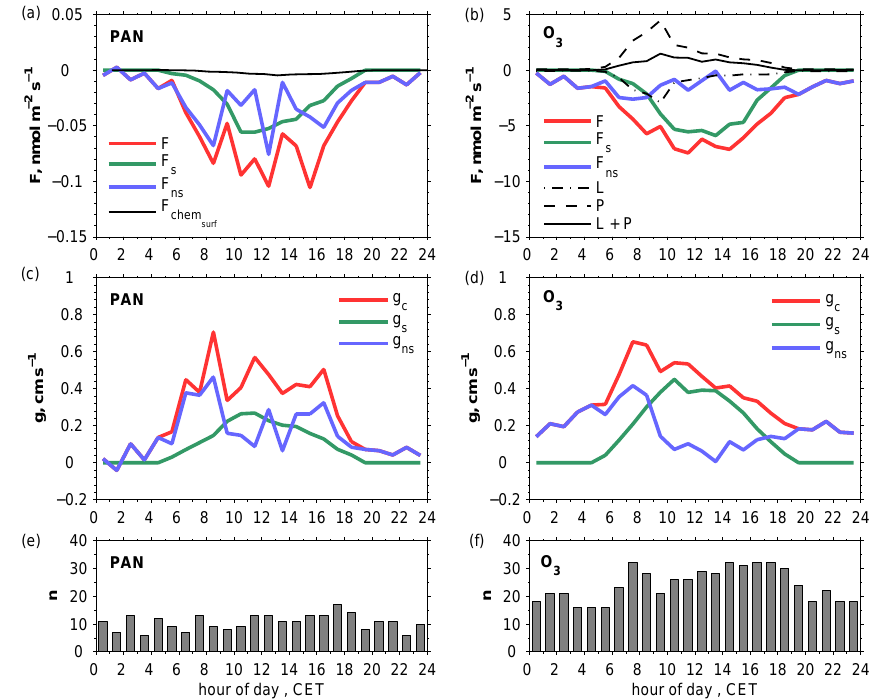
Figure 4. Flux partitioning of PAN (left column) and O 3 (right column) deposition into stomatal and non-stomatal pathways at the Mainz Finthen grassland site. Shown are diurnal median values for the period from 19 August to 4 September 2011. Panels (a) and (b) indicate the deposition fluxes including the thermochemical flux term ( F chem ) for PAN and the loss (L) and production (P) terms for O 3 . Panels surf (c) and (d) show the respective conductances, while (e) and (f) show the number data points used for every hourly interval.